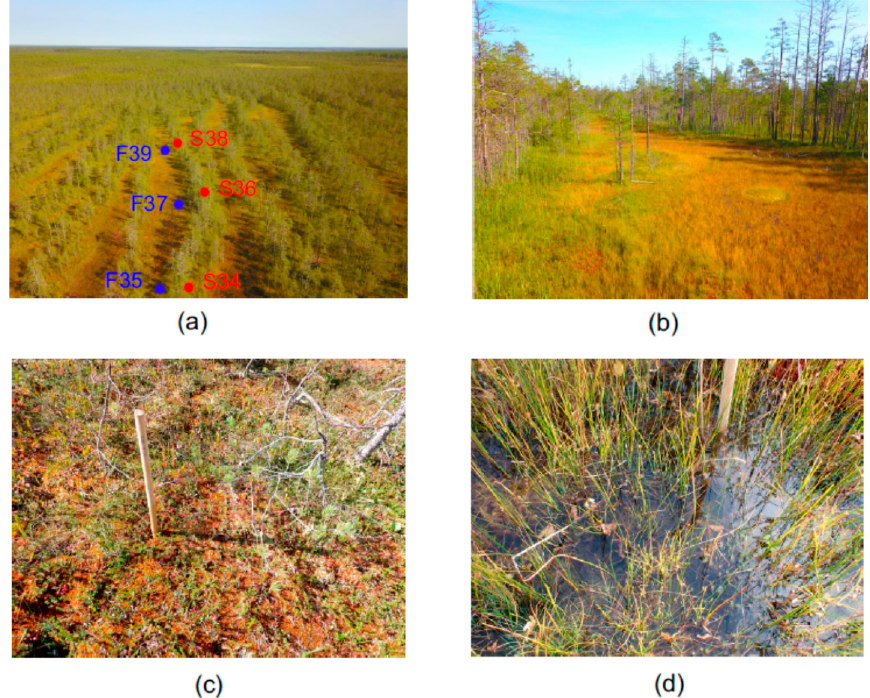
Figure 1. Aapa-type mire in Piyavochnoe mire system. ( a ) Aerial view, approximate positions of sampling sites are marked; ( b ) surface view showing a flark in center, and forest-covered strings on left and right sides; ( c ) sampling site in string; ( d ) sampling site in flark.